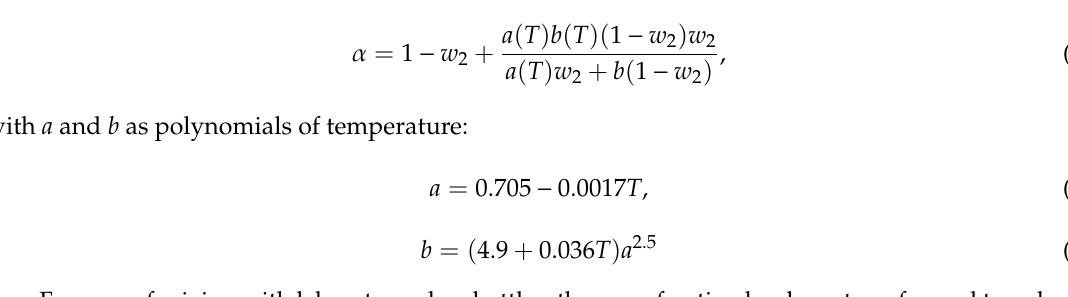
Table 1. Kinematic and dynamic viscosities of different water–glycerol mixtures calculated analytically using Equations (1)–(4).